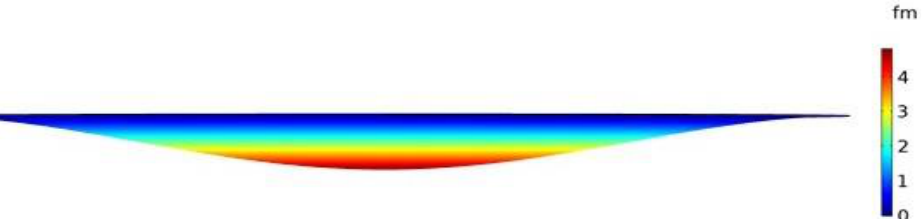
Figure 20. Deformation in a simulated profile for a silicon capacitive clamped membrane with a 20 µm radius and 500 nm membrane thickness. Maximum deflection of about 4 femtometers (fm) is obtained in the middle of the structure, when the capacitive clamped membrane has a 500 nm cavity height while biased with 20 V DC.